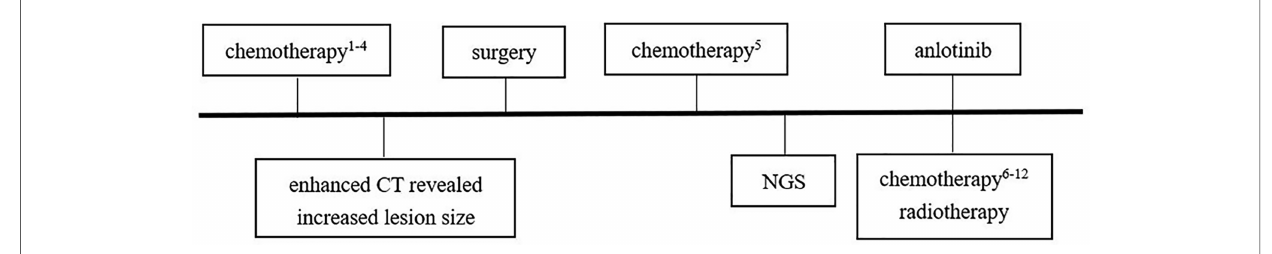
FIGURE 3 Treatment fl ow chart. Chemotherapy 1 – 4 : vindesine 3 mg/m 2 , d1+cyclophosphamide 1.2 g/m 2 , d1+epirubicin37.5 mg/m 2 , d1 – d2 ( fi rst cycle, May 11 – May 12); ifosfamide 1.8 g/m 2 , d1 – d5+etoposide 100 mg/m 2 , d1 – d5 (second cycle, June 3 – June 7); vindesine 3 mg/m 2 , d1+cyclophosphamide 1.2 g/m 2 , d1+epirubicin 37.5 mg/m 2 , d1 – d2 (third cycle, June 27 – June 28); paclitaxel 260 mg/m 2 , d1+cisplatin 20 mg/m 2 , d2 – d5+ifosfamide 1.2 g/m 2 , d2 – d5 (fourth cycle, July 21 – July 25). Chemotherapy 5 : ifosfamide 1.5 g/m 2 , d1 – d5+irinotecan 90 mg/m 2 , d1 – d3+carboplatin 450 mg/m 2 , d2 ( fi fth cycle: August 21 – August 25). Chemotherapy 6 – 12 : irinotecan 90 mg/m 2 , d1 – d3+carboplatin 450 mg/m 2 , d2 (6th – 12th cycles; September 18 – September